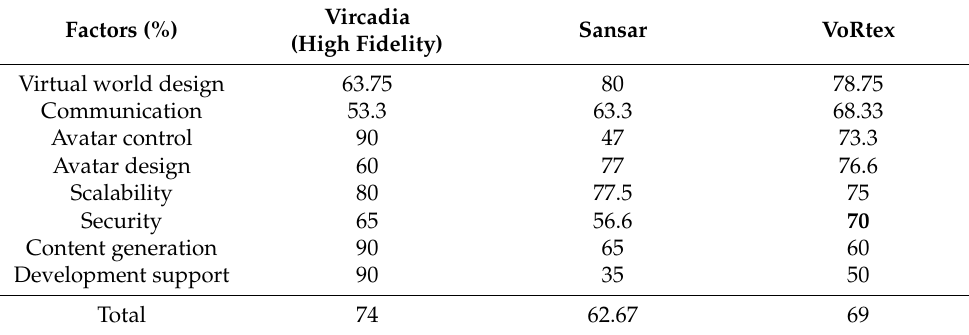
Table 2. Percentage obtained for each